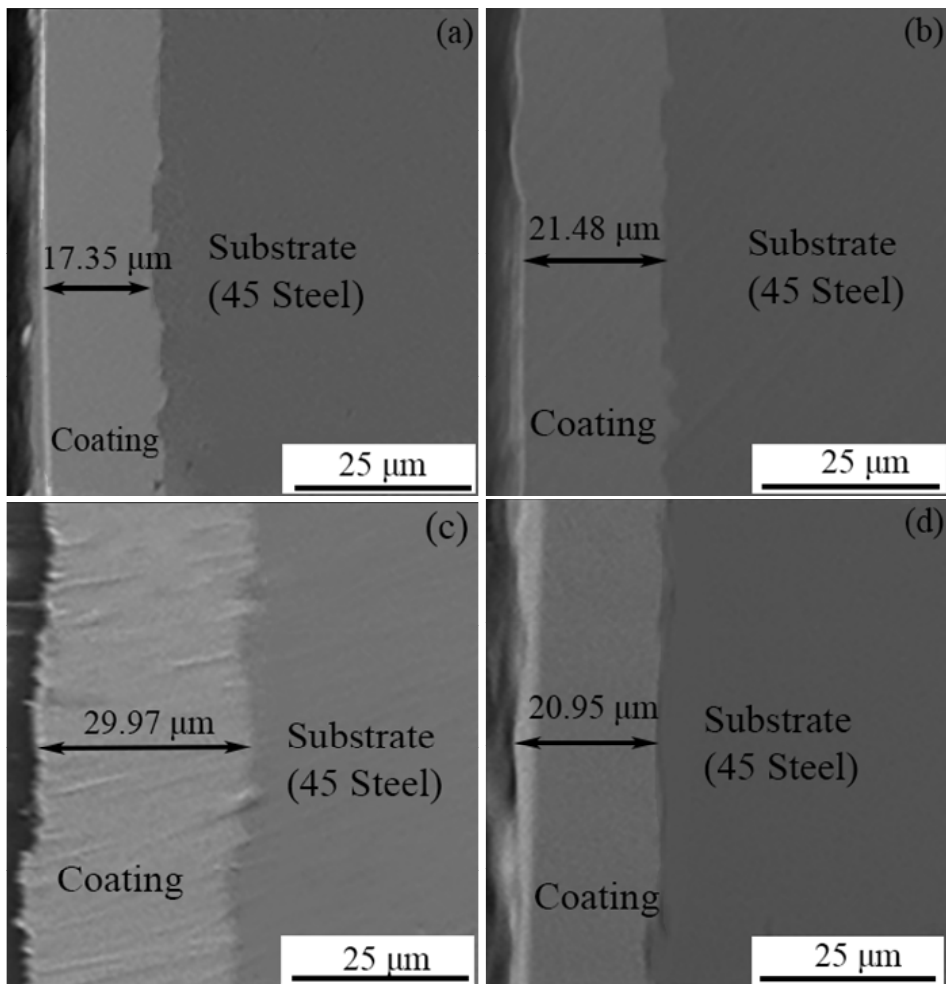
Figure 6. SEM micrographs, illustrating the coating cross section of the Ni-W/SiC nanocomposite coatings obtained at different SiC concentrations—( a ) 0 g L − 1 , ( b ) 3 g L − 1 , ( c ) 6 g L − 1 and ( d ) 12 g L − 1 —on polished 45 steel substrate surfaces.